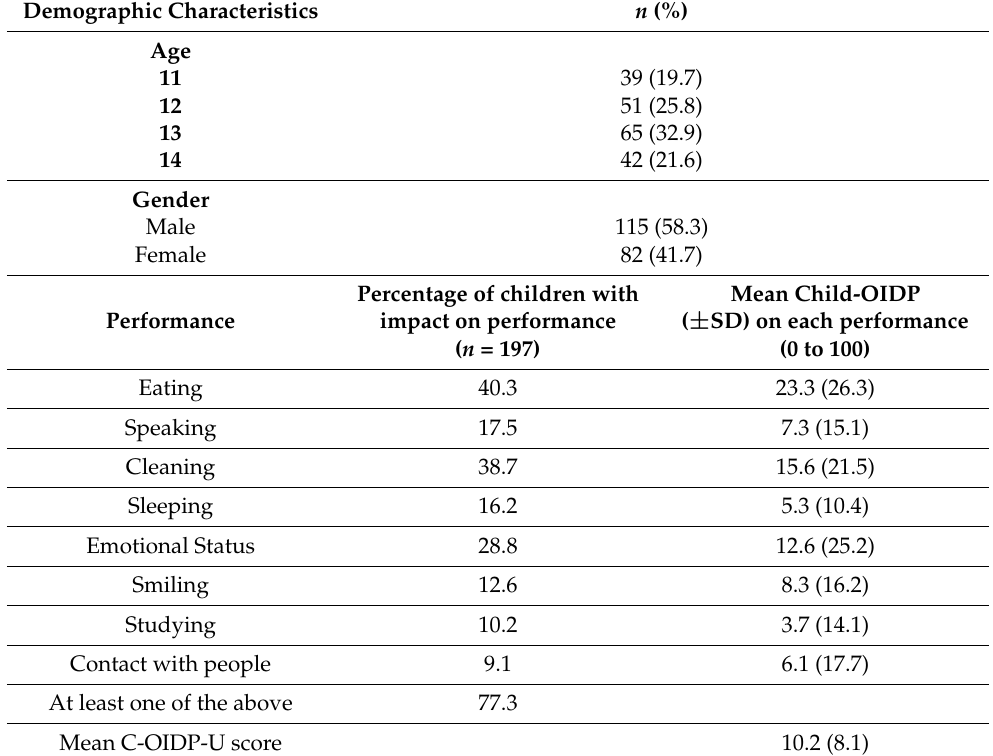
Table 1. Demographic characteristics and prevalence of oral impacts on daily performances (Child- OIDP) in Pakistani children ( n = 197).